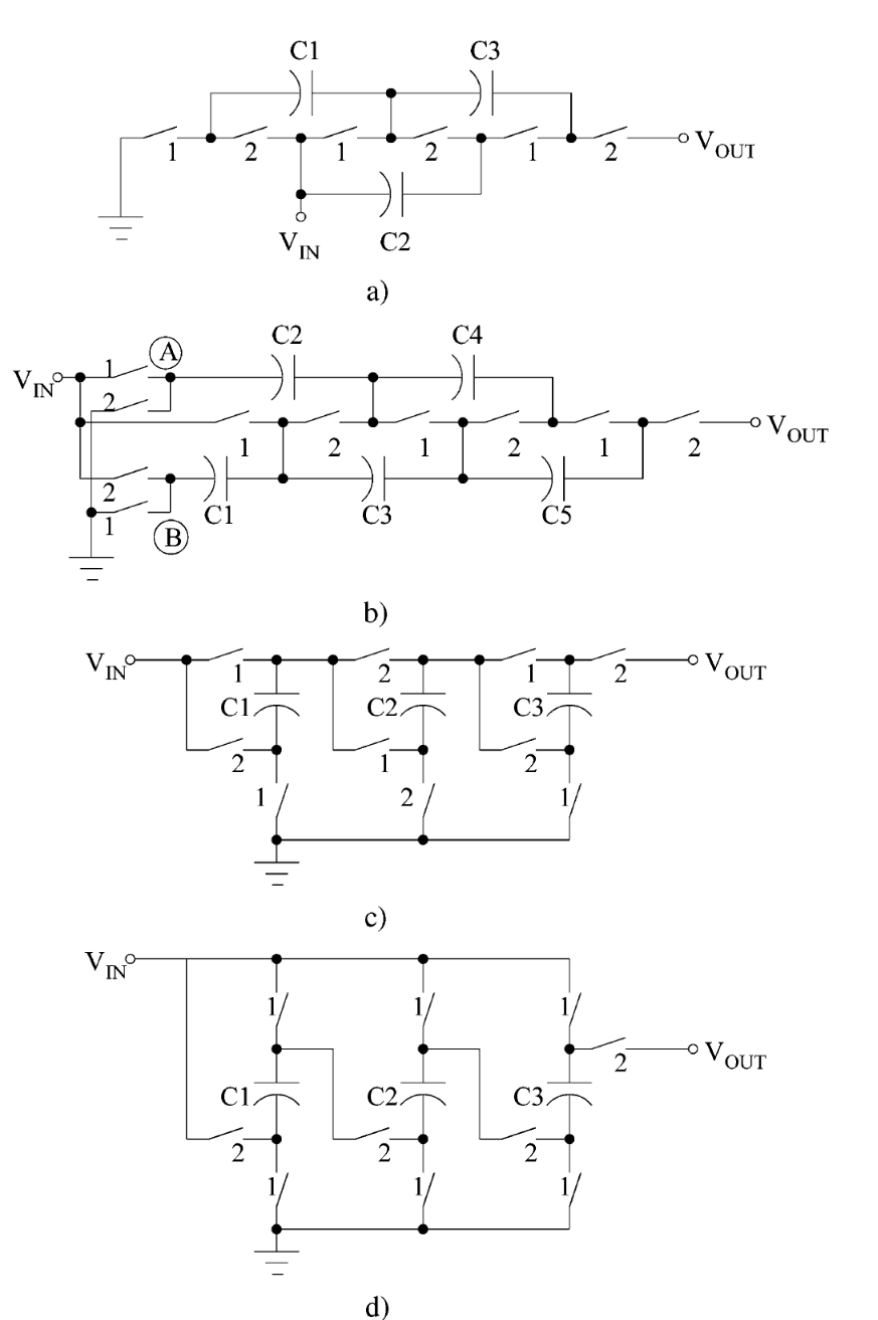
Figure 6. Different topologies of switched capacitor converters: ( a ) the Ladder, ( b ) the Cockcroft– Walton voltage multiplier, ( c ) the Fibonacci, and ( d ) the Series–Parallel